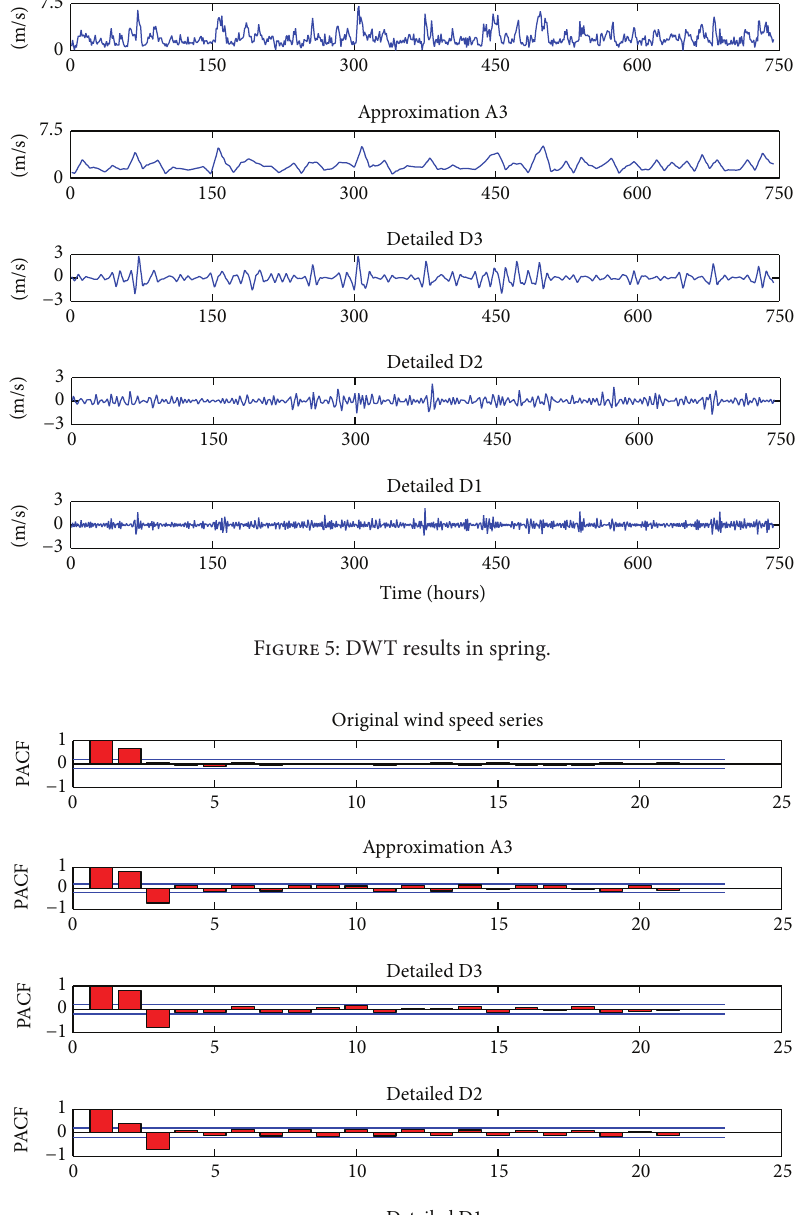
Figure 6: The PACFs of the original wind speed series, low-pass filter, and three high-pass filters (spring).